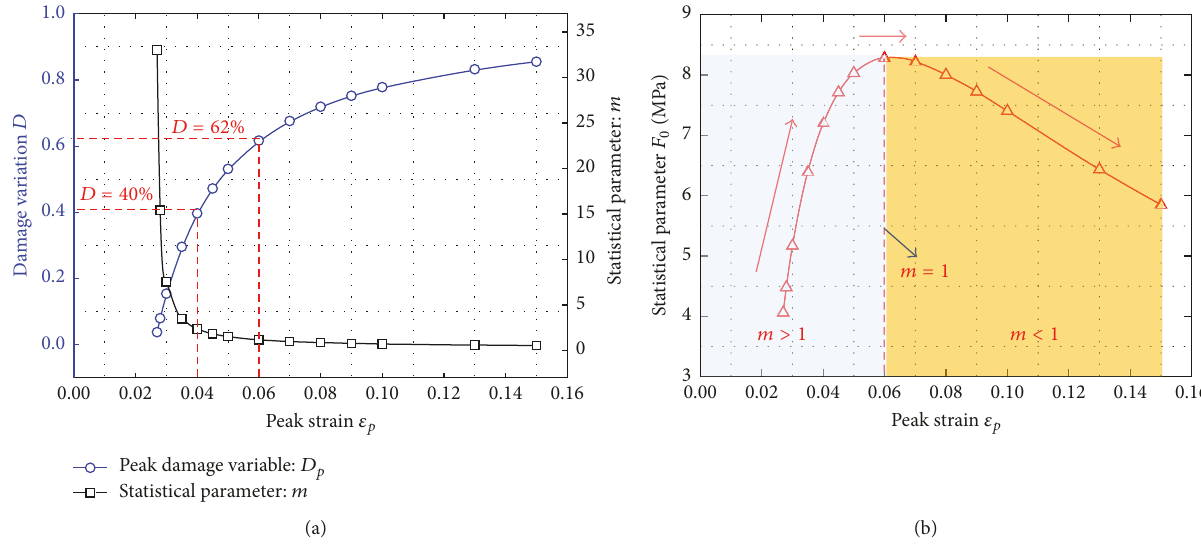
Figure 7: Relationships between physical parameters and statistical parameters. (a) Effects of peak strain on peak damage variable and parameter ( 𝑚 ); (b) effects of peak strain on parameter 𝐹 0